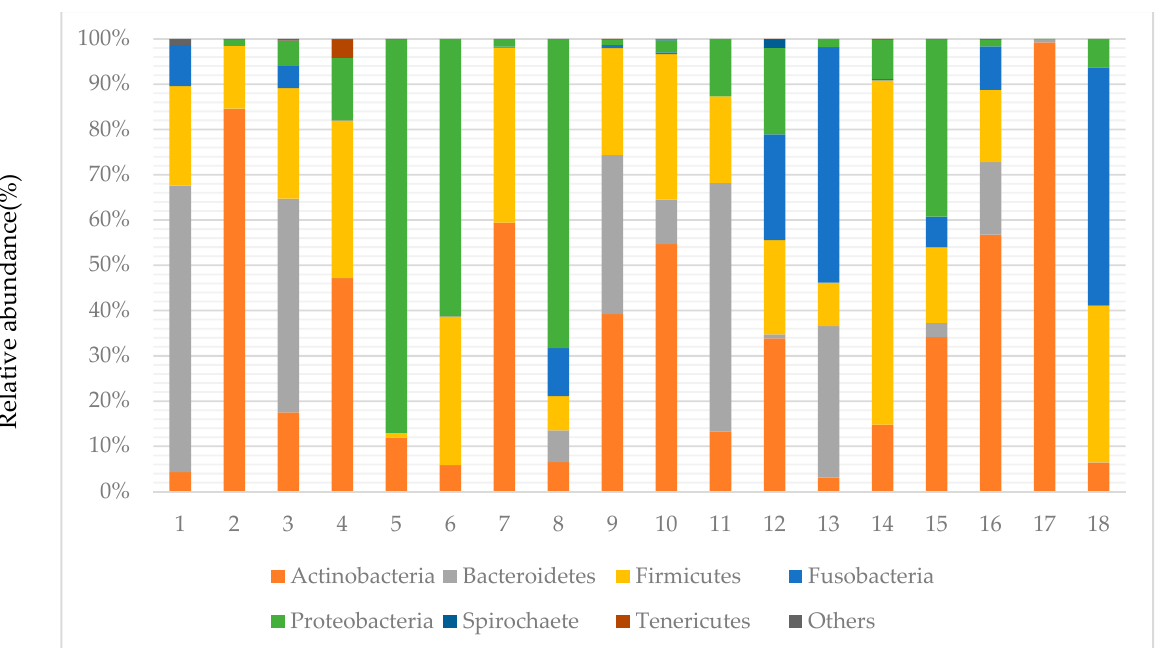
Figure 1. Distribution of bacteria phyla identified by metagenomic analysis of 18 samples obtained from canaliculitis